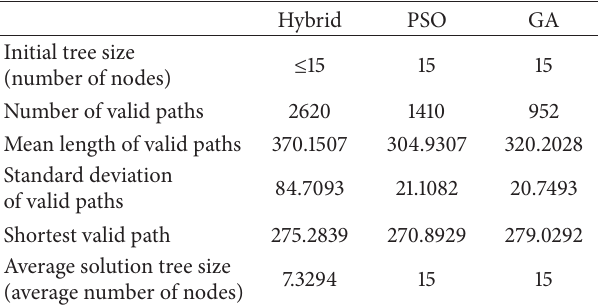
Table 5: Comparison in performance among the proposed hybrid approach, PSO, and GA for test environment II.